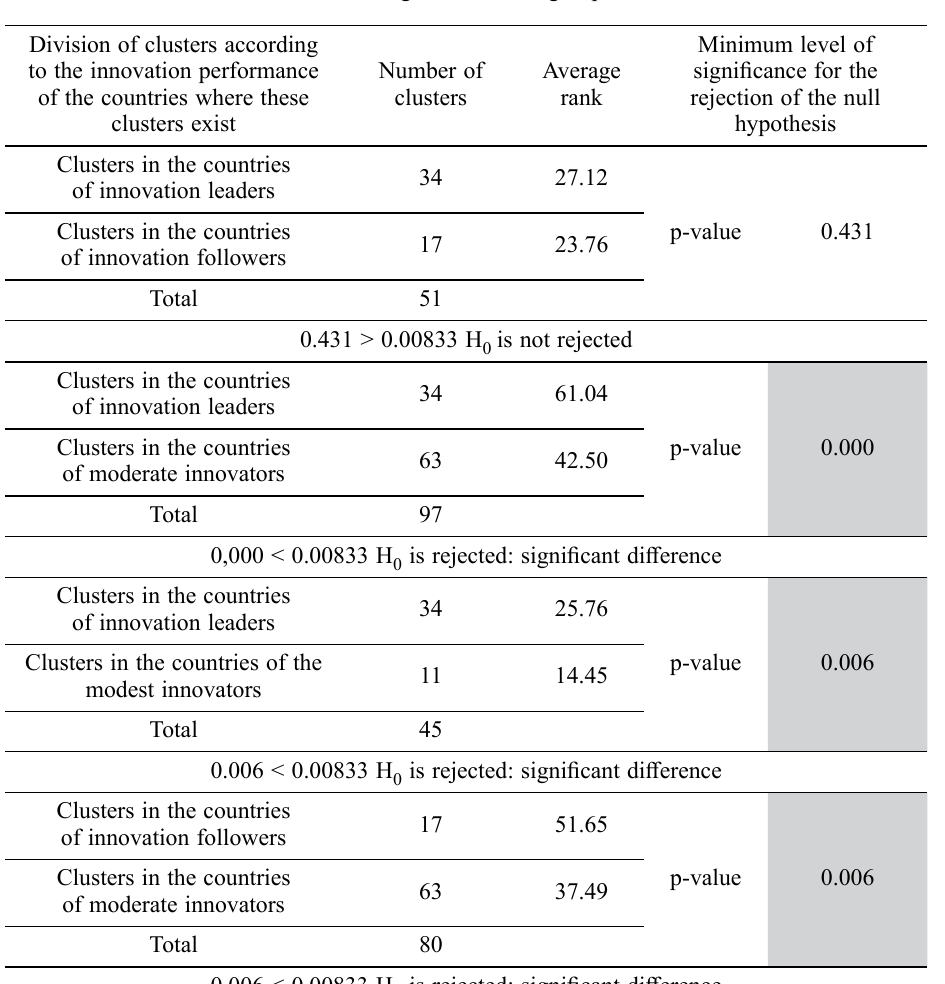
Table 2. Pair comparisons of shares of central government subsidies (governments, ministries) in annual cluster budgets in various groups of